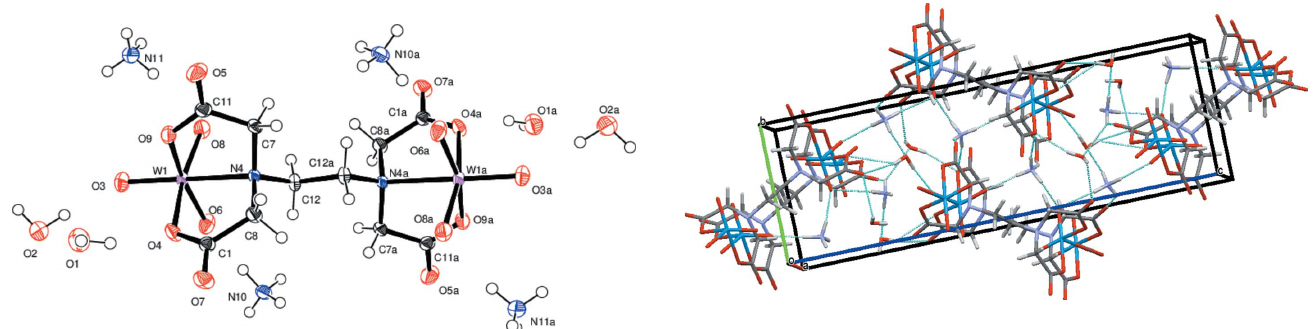
Figure 2 Supramolecular arrangement of the title compound established by classical hydrogen-bonding interactions (dashed